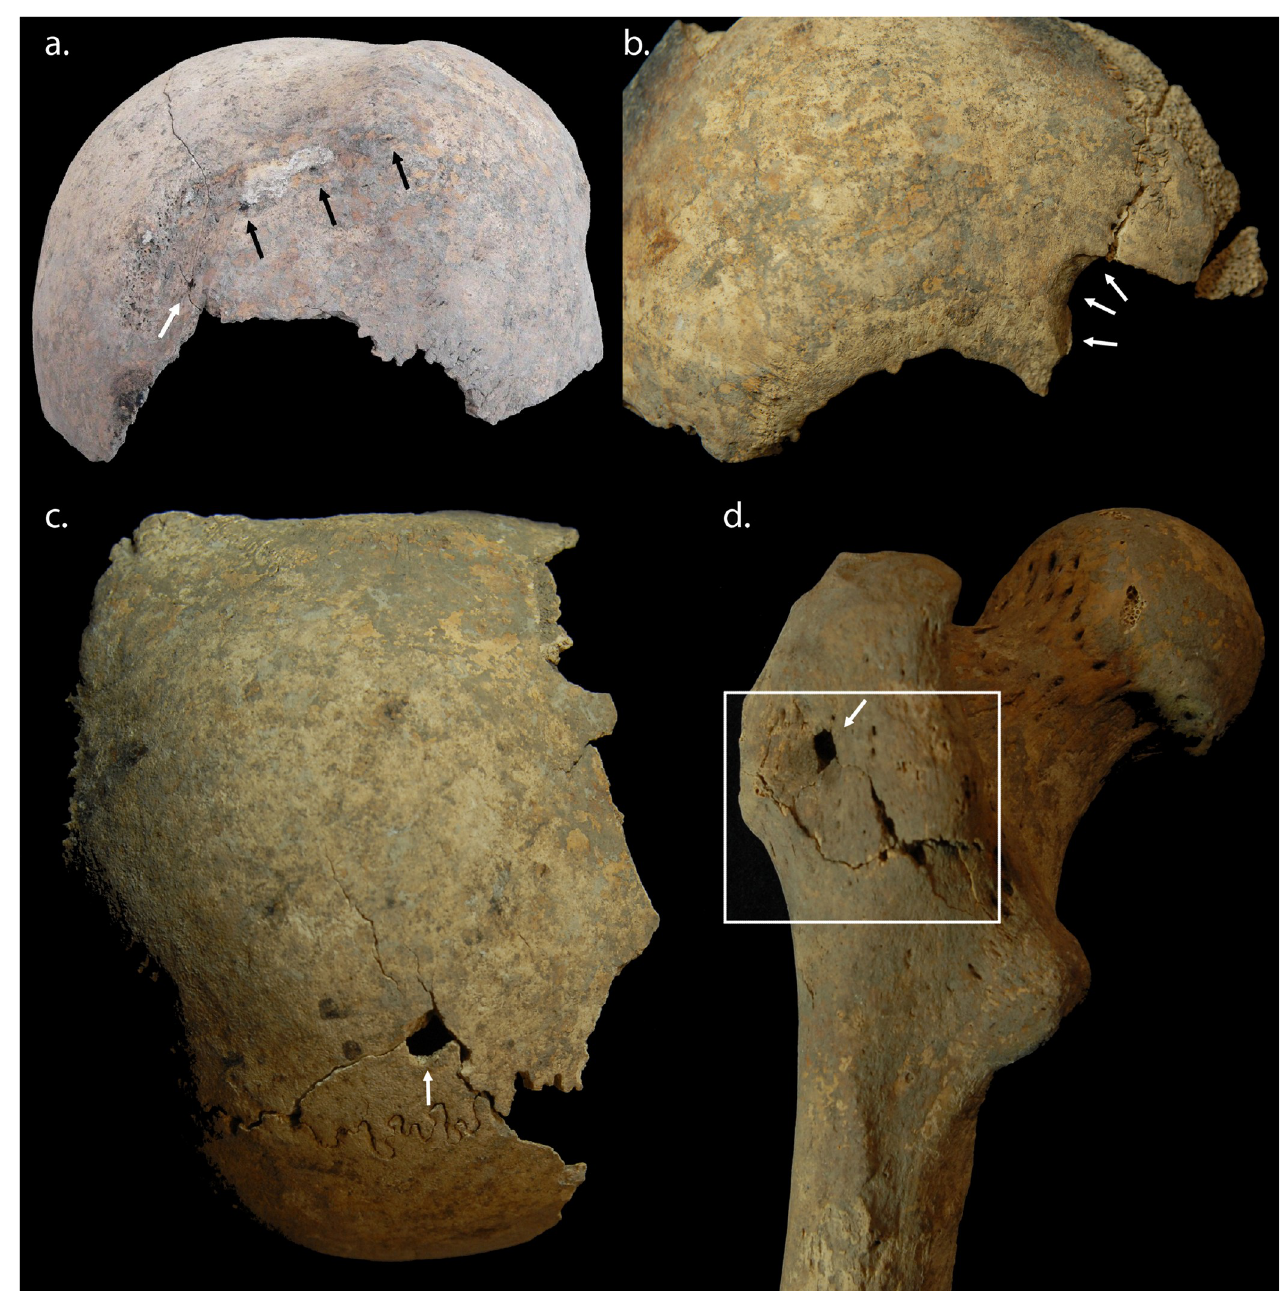
Fig 6. Examples of penetrating force lesions from the Sidon crusader period mass grave deposits: a) A group of associated penetrating lesions evidenced at the time of excavation, suggestive of a multiple-pointed implement, such as a spiked mace, rolling across the cranium; b) Large penetrating lesion to the anterior right side of another cranium, demonstrating evidence of healing, indicating this wound was likely inflicted during a separate violent incident; c) Well- defined, rectilinear penetrating lesion to superior left parietal; d) Well-defined rectilinear penetrating lesion to posterior aspect of greater trochanter of a left femur, with associated blunt force evidenced by radiating fractures and an area of crushing to the bone around the inferior aspects of the lesion (photos: R.